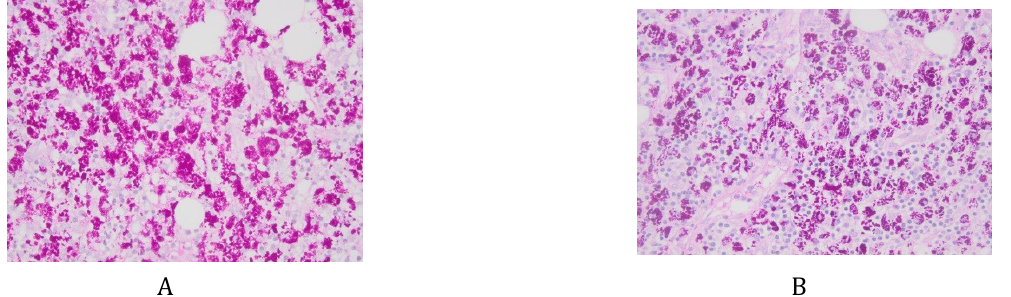
Figure 4. Numerous intra-cytoplasmic particles positive for PAS stain and PAS diastase. A: PAS stain, ×100; B: diastase stain, ×100